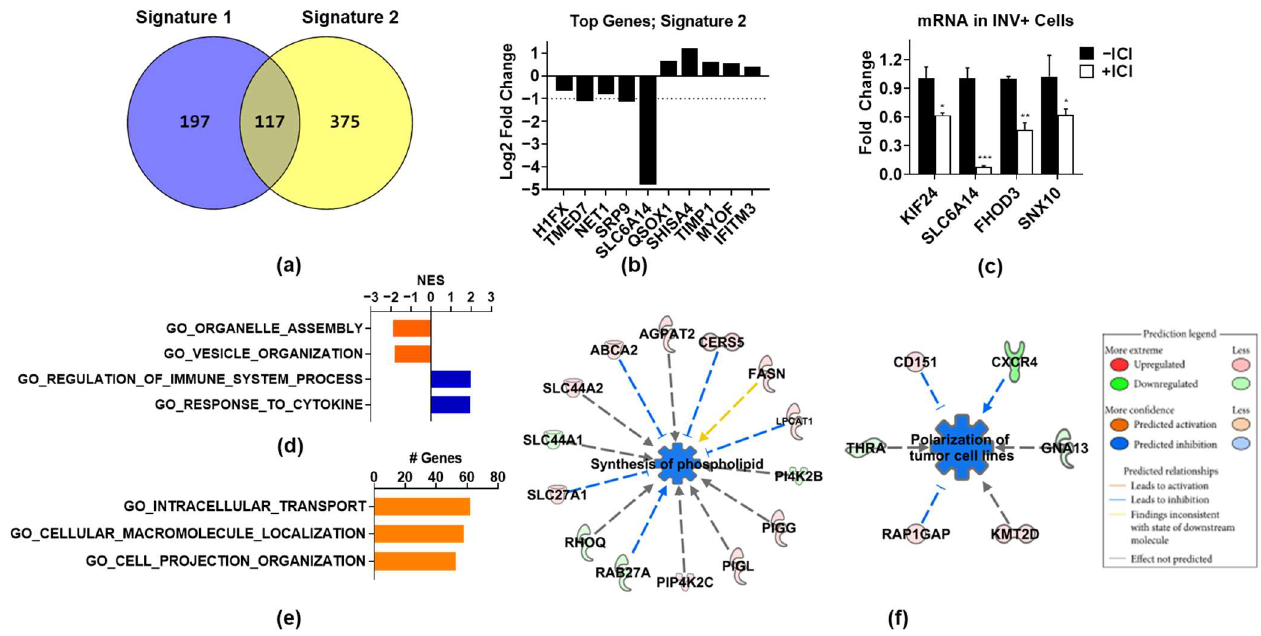
Figure 3. ER regulates the expression of genes associated with intracellular trafficking in invasive cells, and disruption/inhibition of vesicle formation. ( a ) Signature 2 genes were identified by applying a cutoff of 0.25 log2 fold change and FDR < 0.01 to all genes significantly regulated (FDR < 0.05) by ICI in INV− and INV+ cells, then genes exclusively regulated in INV+ cells had cell-cycle-associated genes removed. Overlap with Signature 1 is shown. ( b ) Log2 FC expression of top regulated genes. ( c ) Validation of top regulated genes by ICI in INV+ cells by QPCR. Statistical significance was determined using one-way ANOVA vs. -ICI group. * p < 0.05; ** p < 0.01; *** p <